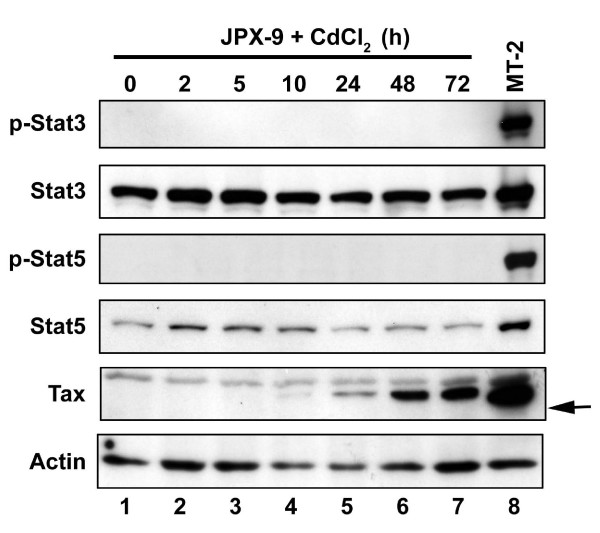
HTLV-1 Tax does not involve in phosphorylation of Stat3 and Stat5. Cell lysates were prepared from CdCl2-treated JPX-9 cells at the indicated time points (lanes 1–7) and untreated MT-2 cells (lane 8: as a positive control). The expression of phospho-Stat3, Stat3, phospho-Stat5, Stat5 and Tax (arrow) was analyzed by Western blot. Actin expression served as a loading control.